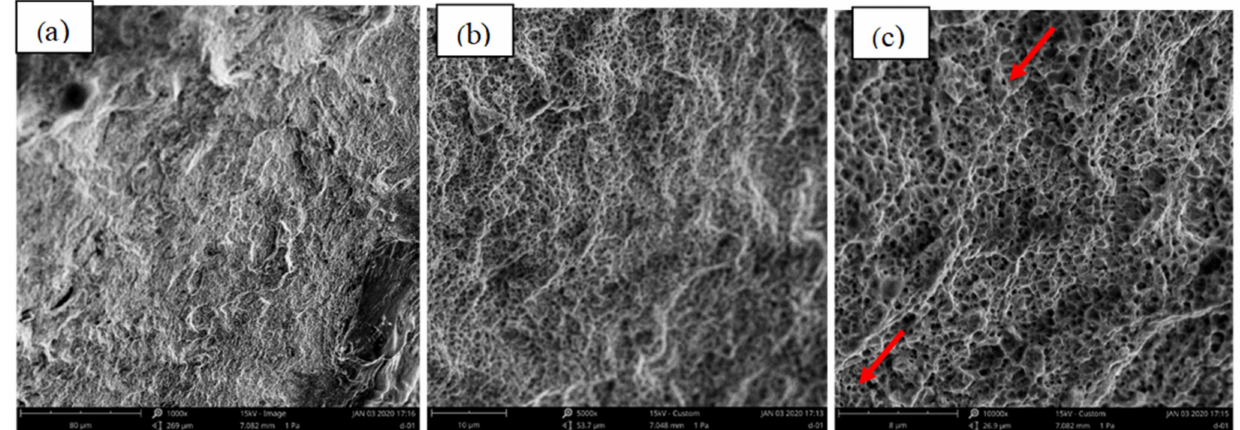
Figure 9. The fracture morphology of group 8—Medium Tensile Strength in Table 4, ( a ) × 1000, ( b ) × 5000, ( c ) × 10,000 (red arrow represents the micro-holes).